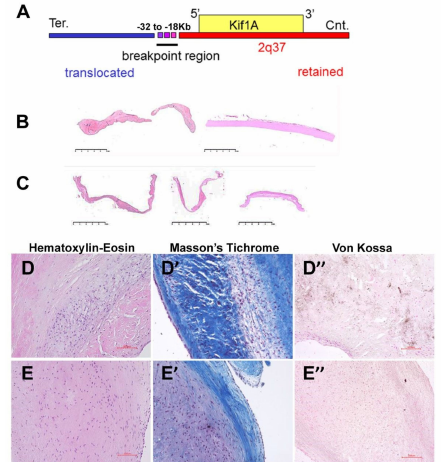
Figure 1. Patient with left-sided heart defects associated with a t(2,8;q37,p11) balanced